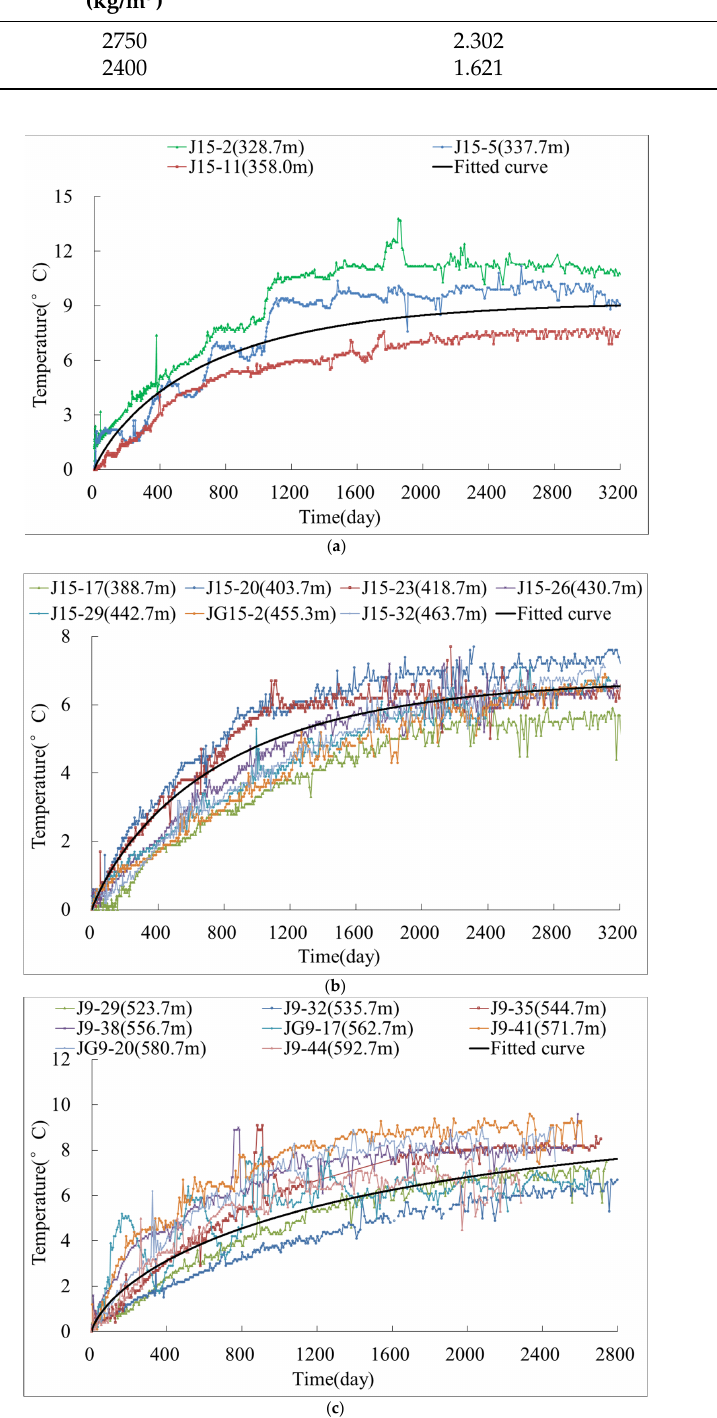
Figure 10. The concrete temperature rise process line. ( a ) C40 concrete; ( b ) C35 concrete; ( c ) C30 concrete.